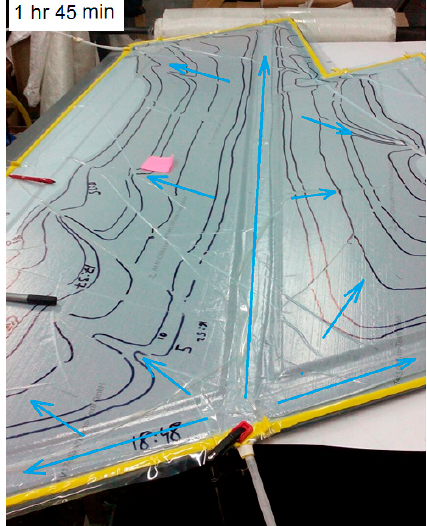
Figure 7. The resin front positions during the vacuum infusion of the tail sandwich panel.